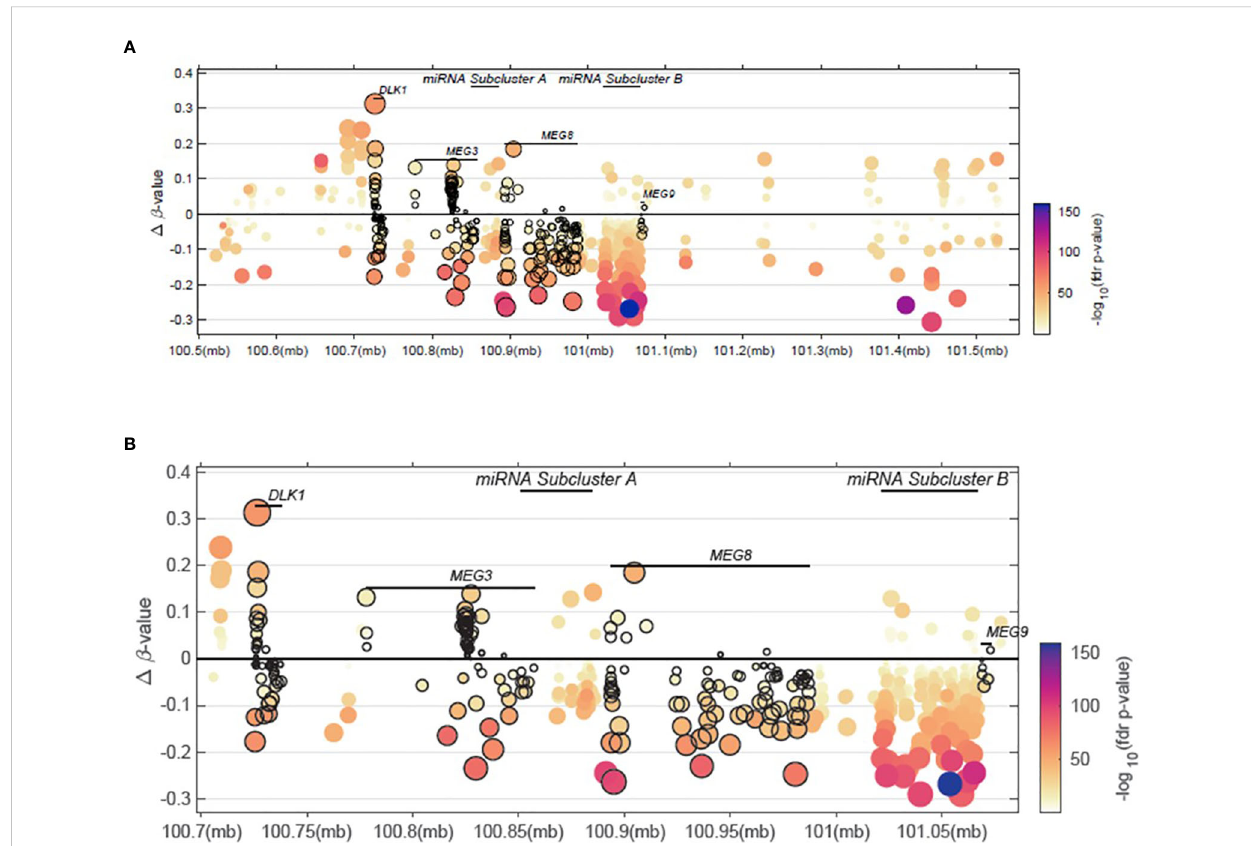
FIGURE 4 Methylation patterns within the 14q32 region of interest. (A) Delta b -values across a 14q32 region encompassing <100.6MB to >101.5MB is shown. (B) Delta b -values from a 14q32 region focusing on <100.75MB to >101.05MB is shown, spanning the DLK1 , MEG3 , miRNA subcluster A, MEG8 , and miRNA subcluster B